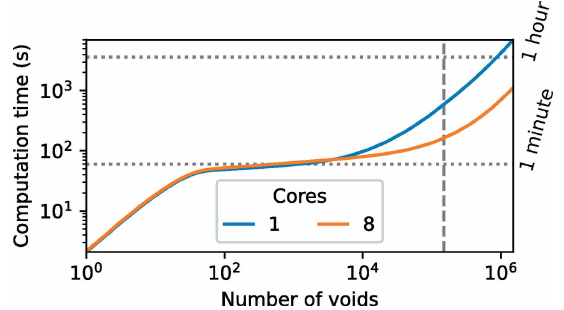
Figure 10 The required computation time for generating a foam phantom as a function of the number of voids in the phantom. The number of voids of the phantom that was used in most experiments in this paper (150000 voids) is indicated by the vertical dashed line.